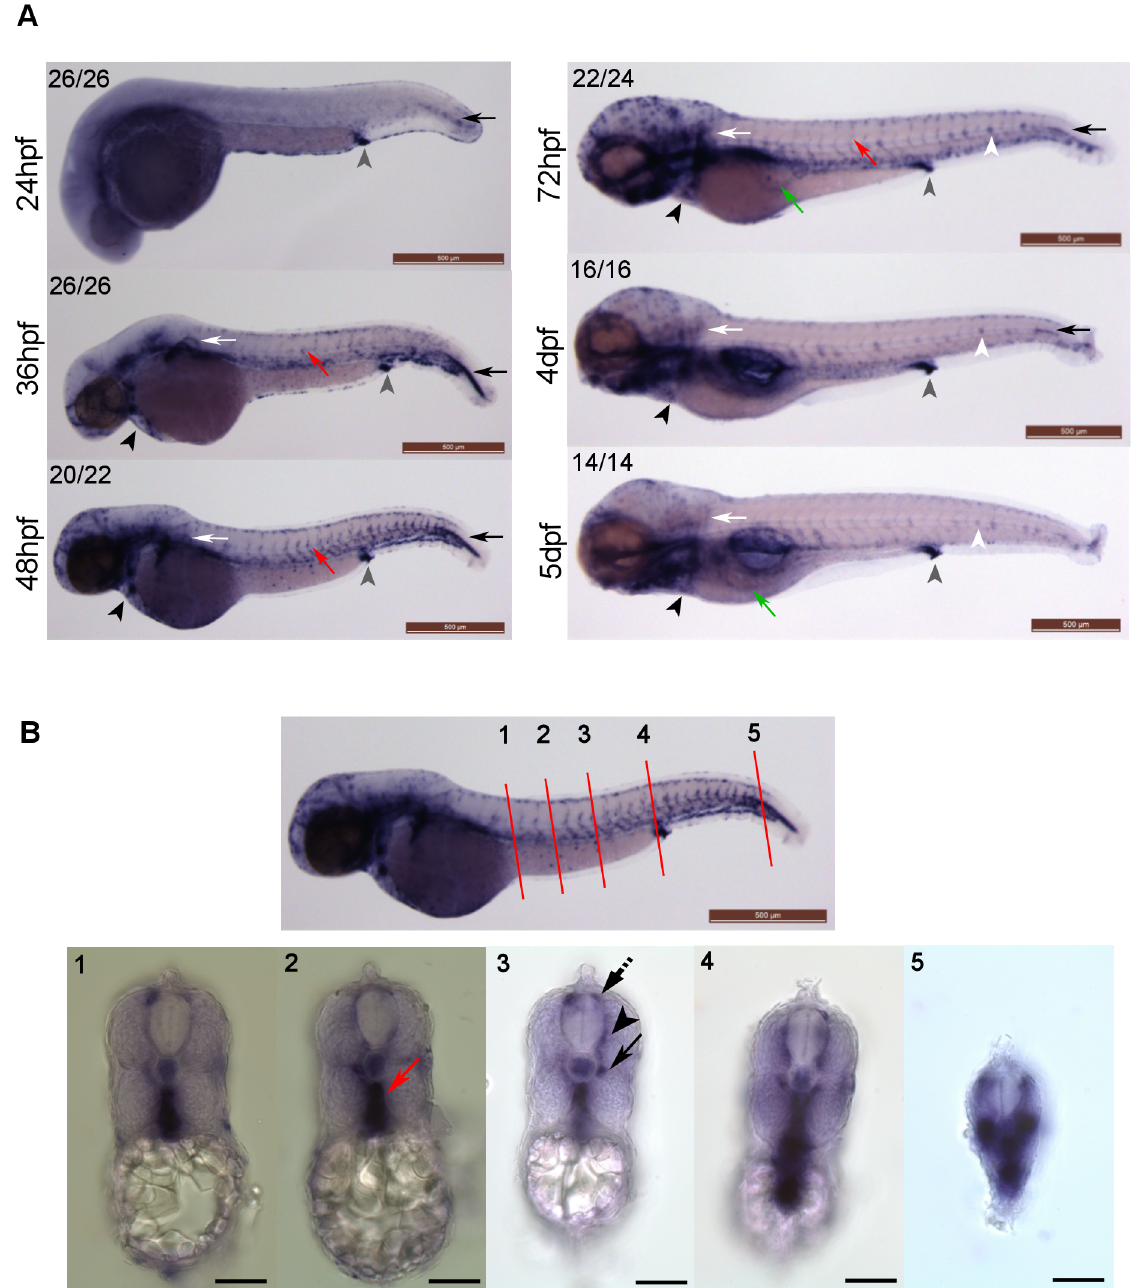
Fig 1. klf2a expression patterns in developing zebrafish embryos. (A) klf2a expression patterns were examined using whole-mount in situ hybridisation. Grey arrowheads indicate cloaca, black arrows indicate cells lateral to the most posterior notochord, white arrows indicate pectoral fin, red arrows indicate trunk vasculature, black arrowheads indicate the cardiac outflow tract, white arrowheads indicate neuromasts and green arrows indicate subintestinal veins (3dpf) or hepatic portal vein (5dpf). Numbers in the top left corners indicate number of embryos with similar staining patterns out of total number of embryos examined. Scale bar = 500 μ m. (B) Cross sections of a 48hpf wildtype embryo showing klf2a expression in dorsal aorta (red arrow), parachordal vessel (black arrow), intersegmental vessel (ISV) (black arrowhead) and dorsal longitudinal anastomotic vessel (DLAV) (dotted black arrow). Anatomical positions of sections are indicated by the red lines and numbers on the top panel figure with corresponding cross sections images in the bottom panel. Scale bar = 500 μ m (top panel) and 100 μ m (bottom panel).